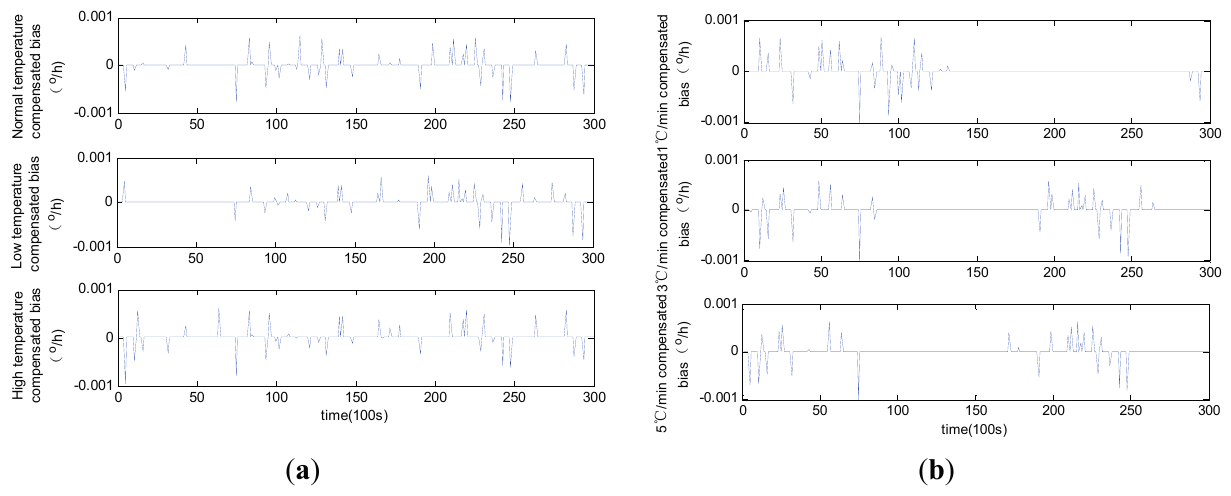
Figure 11. Compensated zero bias history using modified RBFNN: ( a ) constant temperature; ( b ) variable